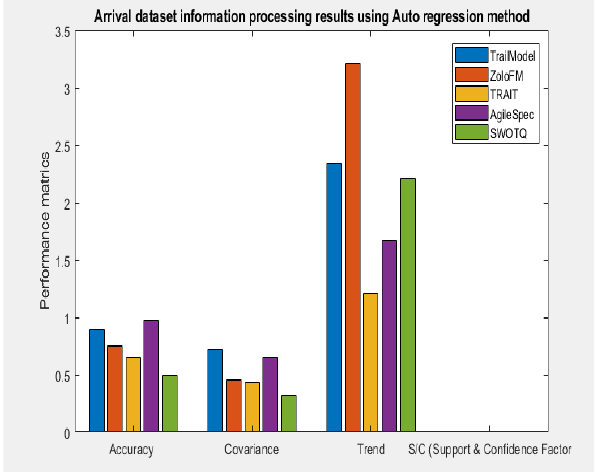
Figure 4. Arrival dataset information processing results using the Autoregression method